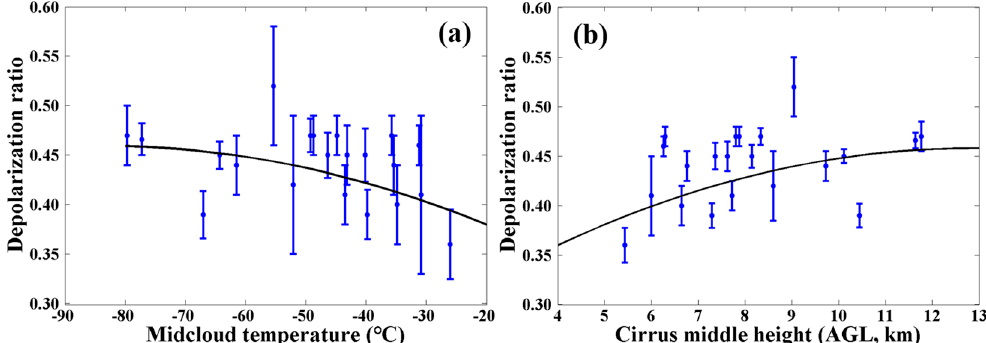
Figure 5. (a) Scatter diagram and correlation of depolarization ratio and midcloud temperature, (b) Scatter diagram and correlation of depolarization ratio and cirrus middle height. The black lines indicate the fitting curves.